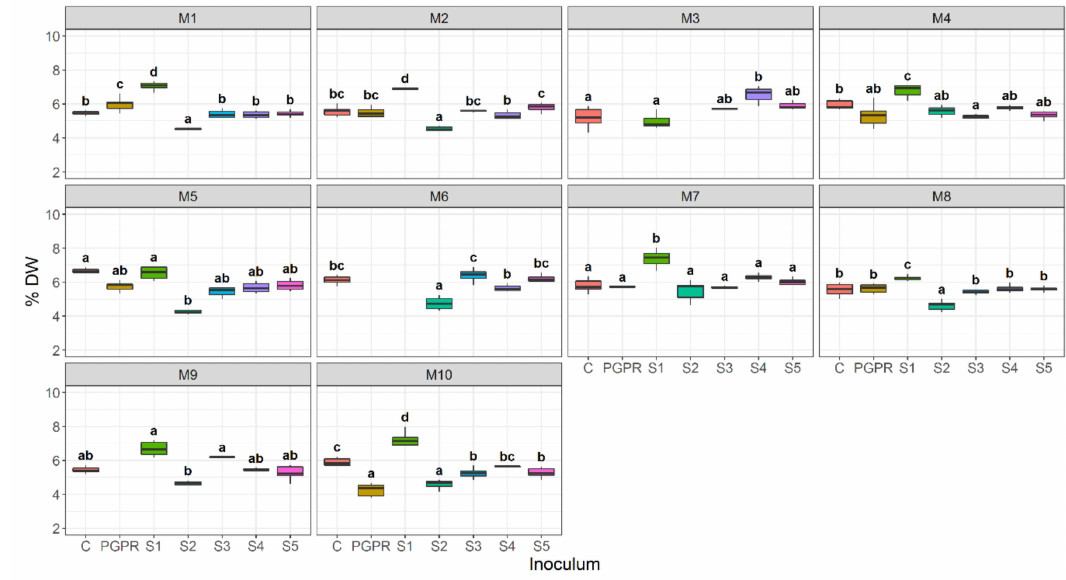
Figure 3. Boxplot of shoot dry weight (%DW) grouped per plant growing medium. Letters show comparison of BCI means per plant growing medium at the 95% confidence level. S indicates the bacterial community inoculum, M indicates the plant growing medium, C indicates the negative control treatment without addition of inoculum, and PGPR indicates the positive control treatment with a Bacillus sp. inoculum. Number of plants ≥